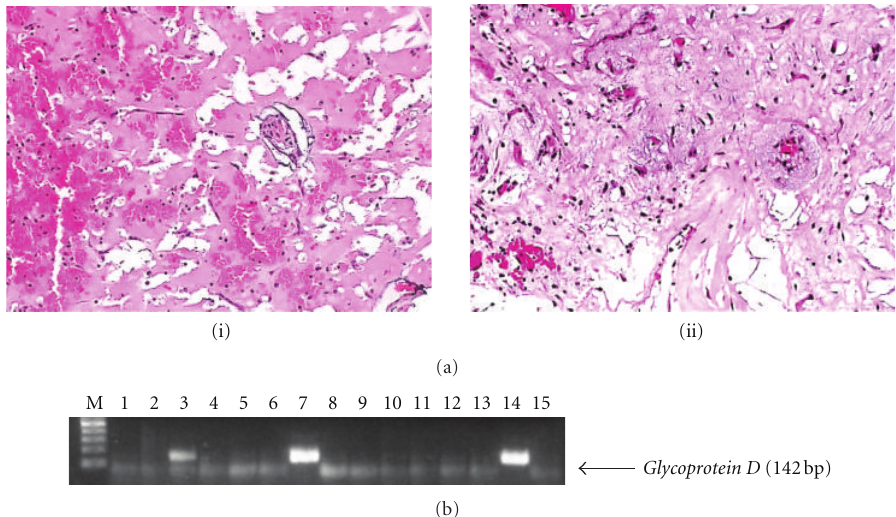
Figure 1: (a) Histological evaluation of representative HSV-positive and HSV-negative cardiac myxoma cases. Hematoxylin-eosin (H&E) staining of myxoma tissue sections revealed sparsely cellular lesions with a characteristic gel-like stroma of acid mucopolysaccharides, containing individual small cells with sparse cytoplasms forming stellate protrusions into the stroma. (i) HSV-negative left atrial myxoma sample (case 1). (ii) HSV-positive right ventricle myxoma sample (case 7) ( × 200 magnification, H&E staining). (b) Detection of HSV DNA in representative atrial myxoma specimens. M: 100 bp molecular marker (New England Biolabs), 1–13: atrial myxoma samples, cases 1, 2,